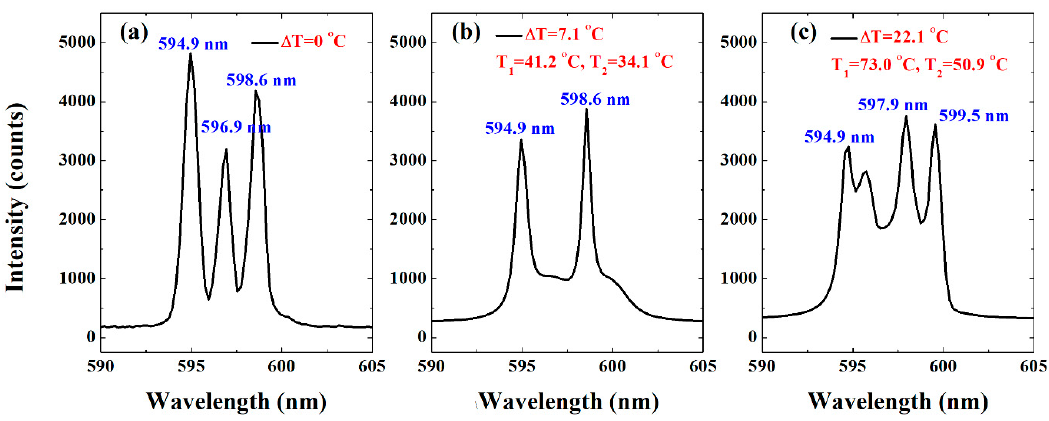
Figure 2. Measured SFG spectra at ( a ) Δ T = 0 °C; ( b ) Δ T = 7.1 °C; and ( c ) Δ T = 22.1 °C temperature differences.